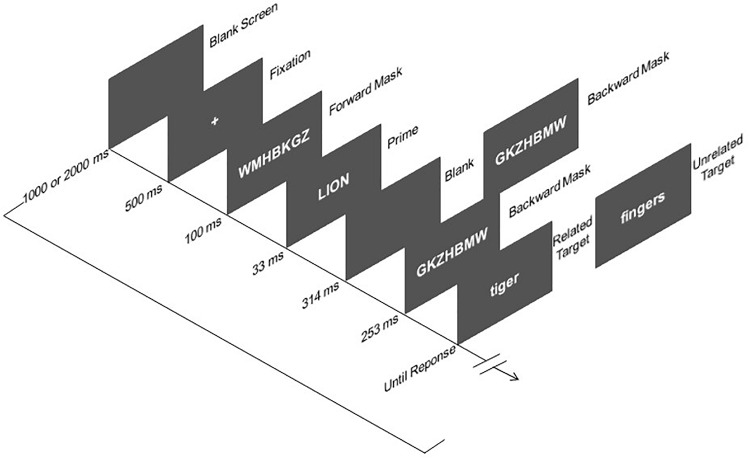
Sequence and time of events in Experiment. The word stimuli shown here for related and unrelated trials have been translated from Spanish to English.